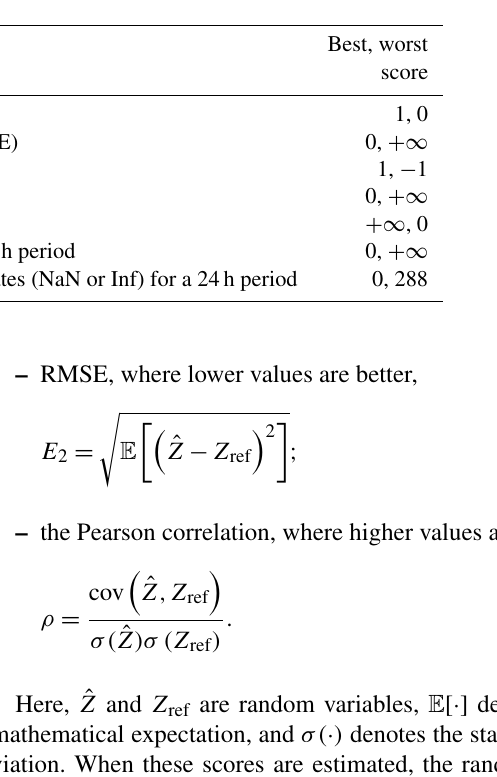
Table 1. Table of metrics used to measure the performance of the K -means for Atmospheric Boundary Layer (KABL) algorithm. The metrics are described in detail in Sect. 3.4. Metric Type Description Best, worst corr External Pearson correlation coefficient 1, 0 errl2 External Root-mean-square error (RMSE) 0, +∞ s_score Internal Silhouette score 1, − 1 db_score Internal Davies–Bouldin index 0, +∞ ch_score Internal Calinski–Harabasz index +∞ , 0 chrono Other Time to estimate BLH for a 24h period 0, +∞ n_invalid Other Number of invalid BLH estimates (NaN or Inf) for a 24h period 0,